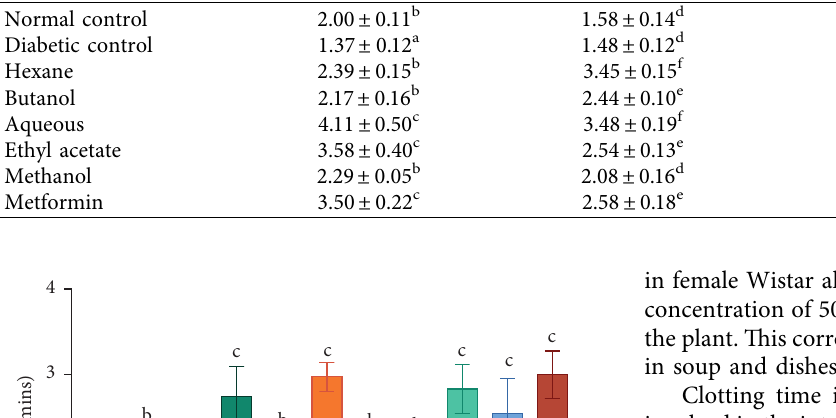
Table 1: Coagulation profile of diabetic rats treated with 100mg/kg body weight of C. crepidioides crude extract and fractions. Parameters group